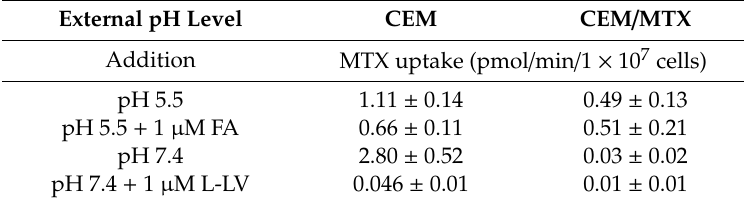
Table 1. MTX uptake at di ff erent pH in CEM and RFC-deficient CEM / MTX cells.